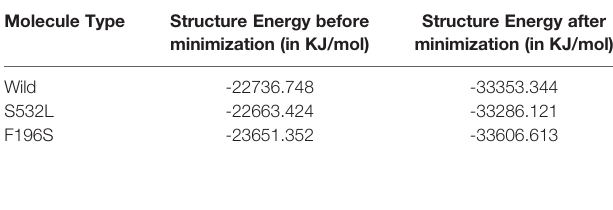
TABLE 3 | ddG values for S532L andF196S mutants on SDMand I-Mutant 2.0.